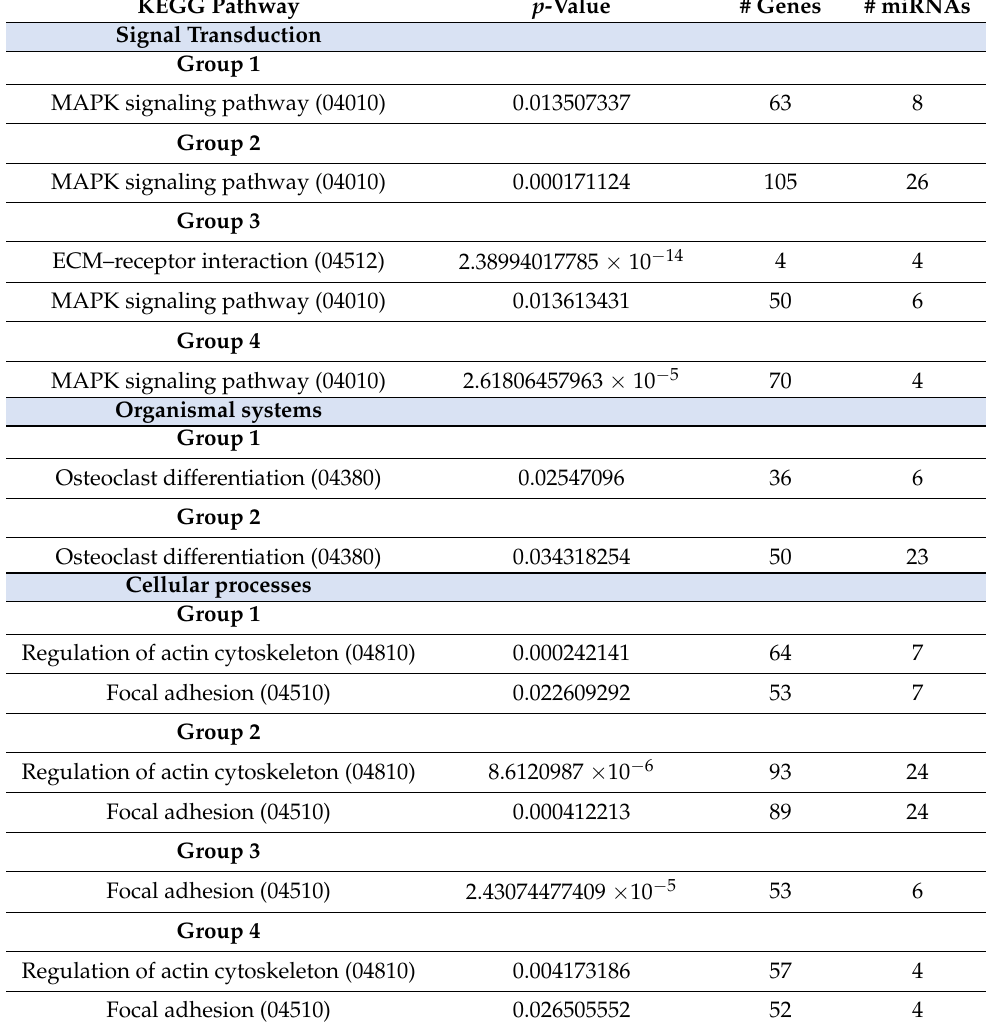
Table 3. KEEG pathways analysis of the differentially expressed miRNAs. Differentially expressed miRNAs were grouped into the following groups (in bold): Group 1, wild-type/upregulated; Group 2, wild-type/downregulated; Group 3, transfected/upregulated; and Group 4, trans- fected/downregulated. Three enriched KEGG pathways are shown (in bold, light blue lines), i.e., signal transduction, organismal systems, and cellular process. p -value, threshold 0.05; # genes, number of genes regulated by miRNAs; # miRNAs, number of miRNAs involved in the KEGG pathway. KEGG Pathway p -Value # Genes # miRNAs Signal Transduction MAPK signaling pathway